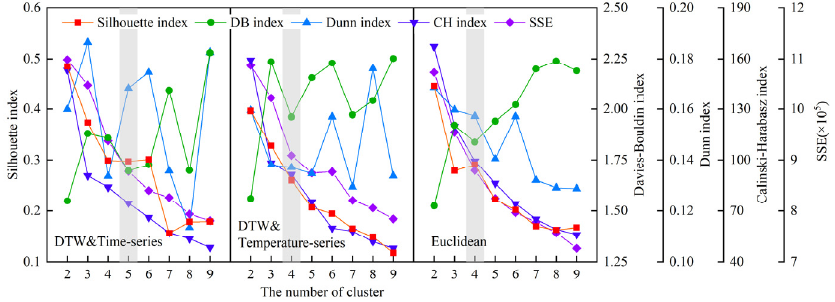
Figure 8. Clustering validation indexes in using different distance metrics and data series.